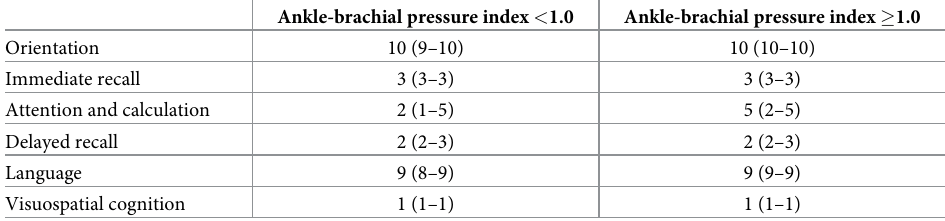
MMSE, Mini-Mental State Examination. Data are presented as median (25% interquartile range [IQR] to 75% IQR). The sub-scores for orientation and immediate recall were significantly lower in the ABI < 1.0 group after adjustment for age, body mass index, education, and chronic kidney disease (p = 0.012 and 0.011,